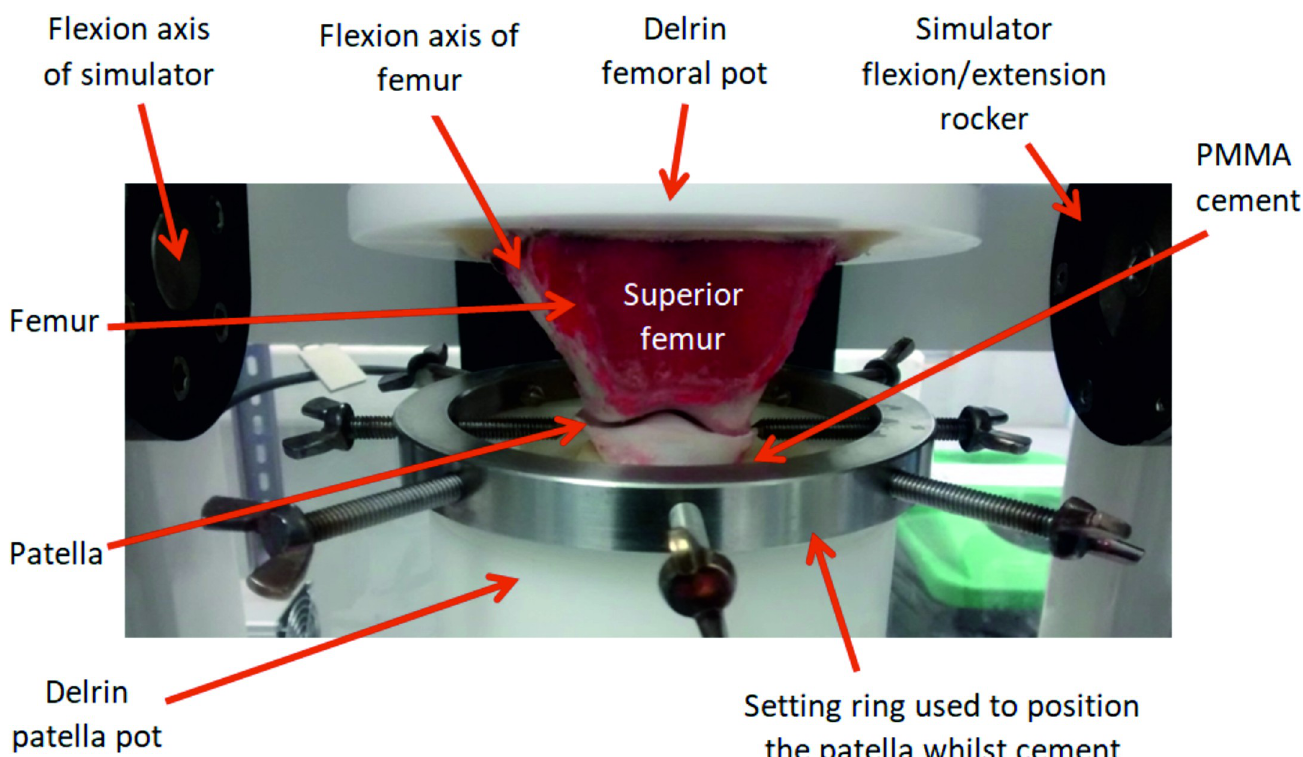
Fig 2. A natural porcine PFJ cemented into custom Delrin fixtures. The centre of rotation of the trochlear groove (flexion axis of the femoral trochlea) aligned with the flexion axis of the simulator, the photograph was taken during cementing of the patella carried out within the simulator with a setting ring used to position the patella whilst the PMMA cement cured.